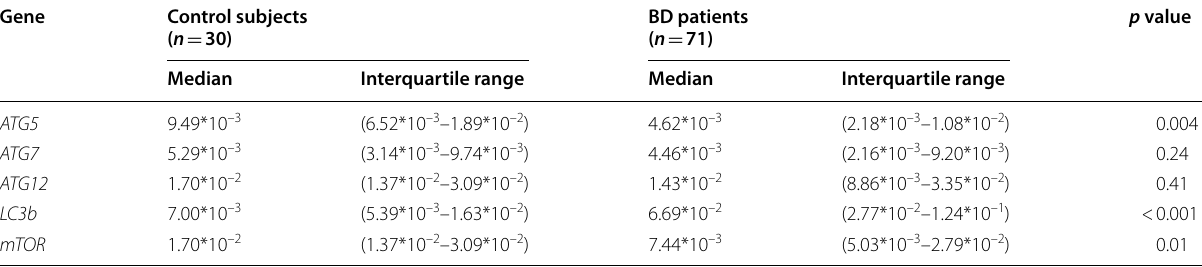
Continues data represented as median and interquartile range (IQR), p considered significant if <